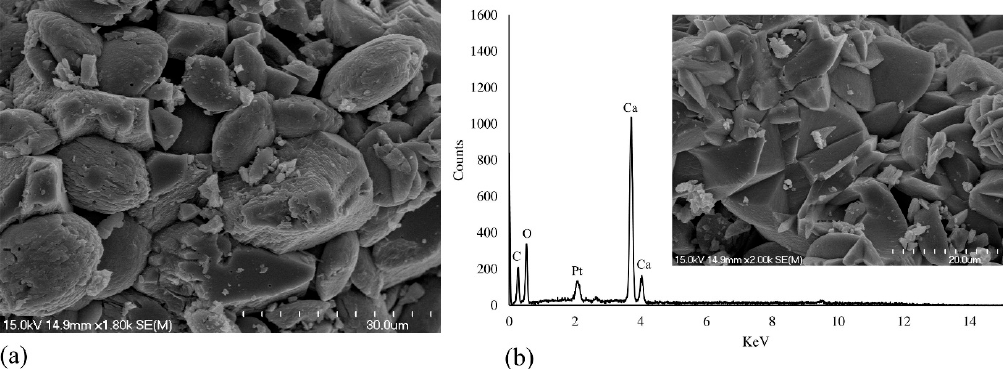
Figure 4. ( a ) Scanning electron microscopy (SEM) micrograph of precipitated CaCO 3 crystals using immobilized bacterial cells into Ca-alginate and ( b ) energy dispersive X-ray spectroscopy (EDS) spectra of the induced CaCO 3 crystal.